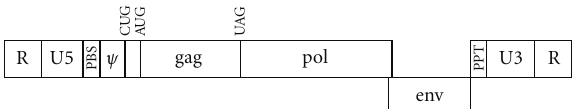
Figure 3: The MLV genome. The viral RNA in Moloney MLV is 8332 nt in length [18]. “R” sequence, 68 nt in length, is identical at both ends of the RNA. The 5 (cid:3) copy of R is followed by U5 sequences and then by the PBS (nt 146–163). The long 5 (cid:3) untranslated region in the RNA also includes the ψ packaging signal; contained within this signal in some MLV isolates is the CUG codon at which glyco- Gag translation is initiated (nt 357). The initiation codon for the “normal” Gag protein is at nt 621. The gag and pol coding sequences are in the same frame; they are separated by a UAG termination codon, which in turn is followed immediately by a 57-base signal, including an RNA pseudoknot, inducing the ine ffi cient translation of the UAG as glutamine. The Env protein is translated from a spliced mRNA. The polypurine tract (PPT, nt 7803–7815) is the primer for +-strand DNA synthesis and is followed by the U3 and R regions. U3 (nt 7816–8264) is placed at the 5 (cid:3) end of the DNA copy of the genome synthesized during infection; it contains promoter and enhancer sequences governing the initiation of transcription at the beginning of